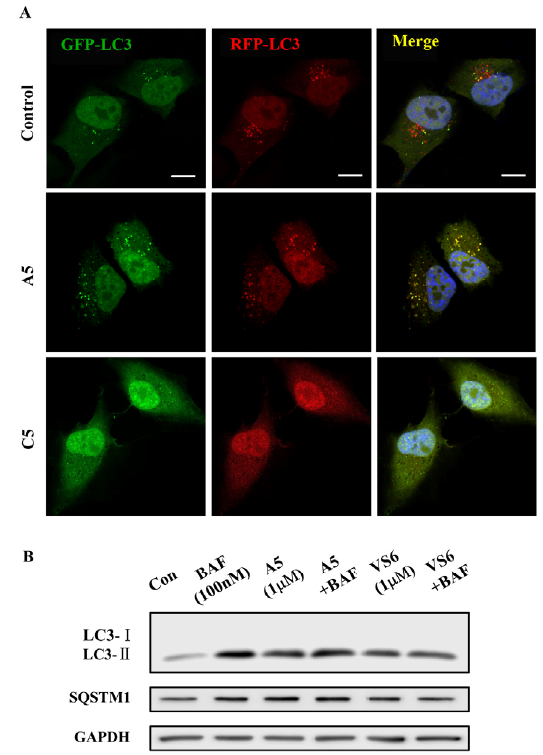
Figure 4. Synthesized vacuolin-1 analogues induced the accumulation of both LC3B-II and SQSTM1 in HeLa cells in a dose dependent manner after a 6 h treatment.